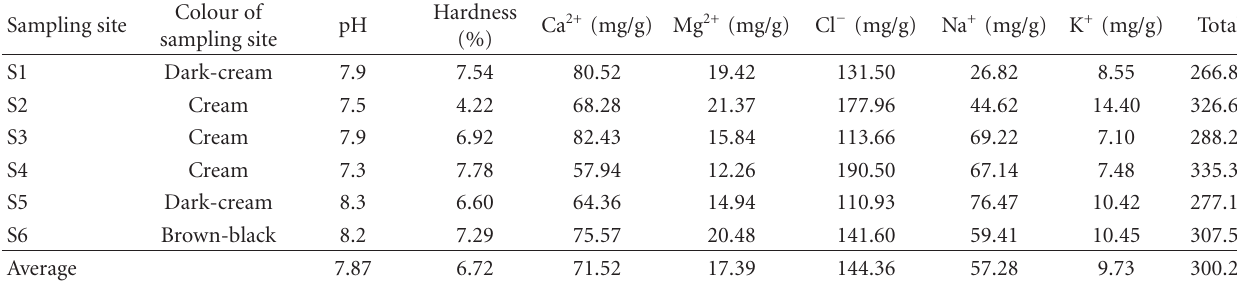
Table 1: Physico-chemical characteristics of the sediment samples. Sampling